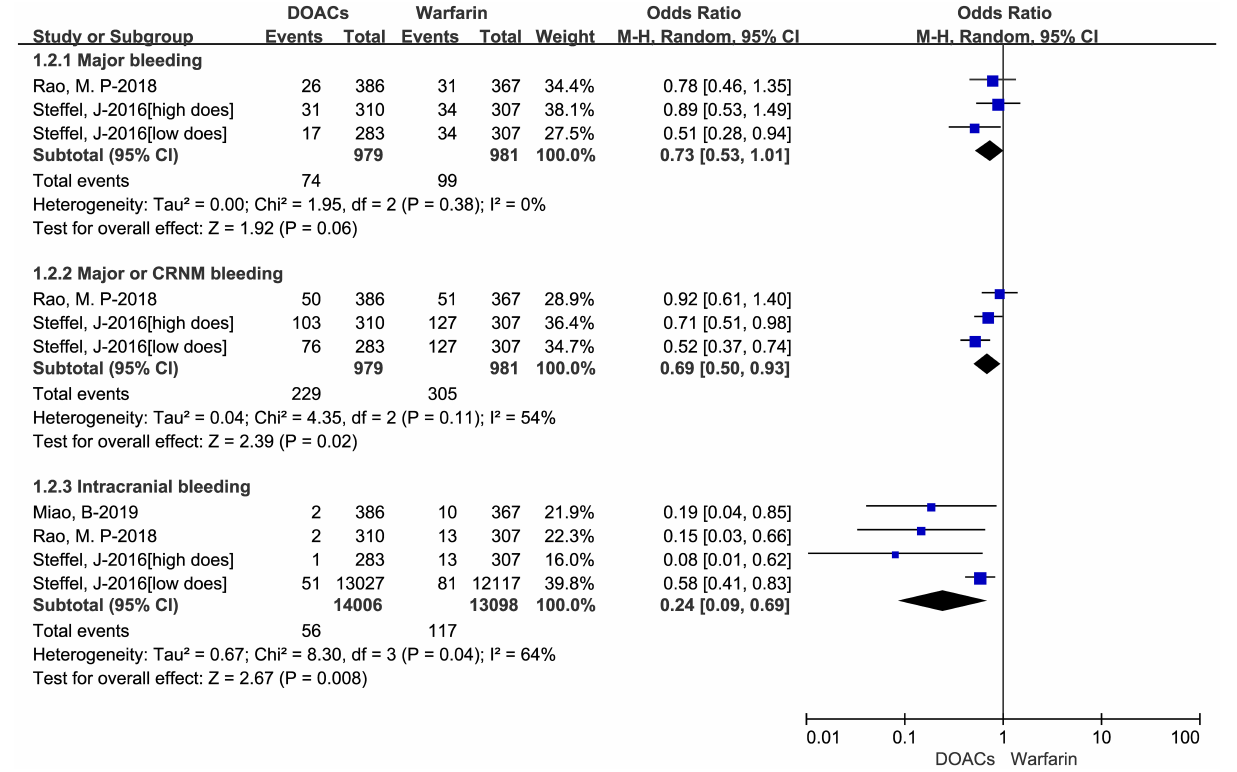
13 remaining studies need to be assessed in more